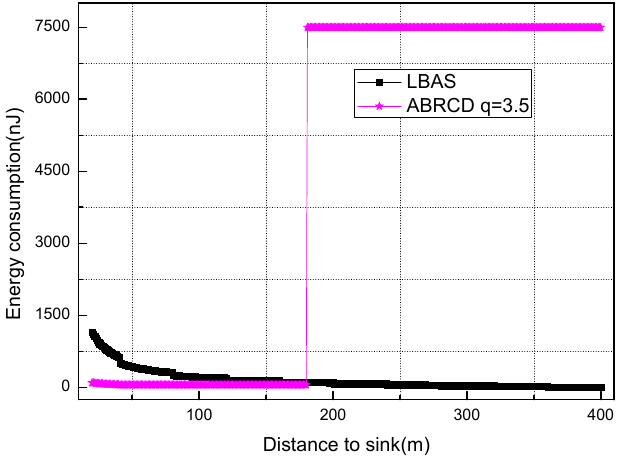
Figure 24. Energy consumption of nodes 20~400 m away from sink with q = 3.5.